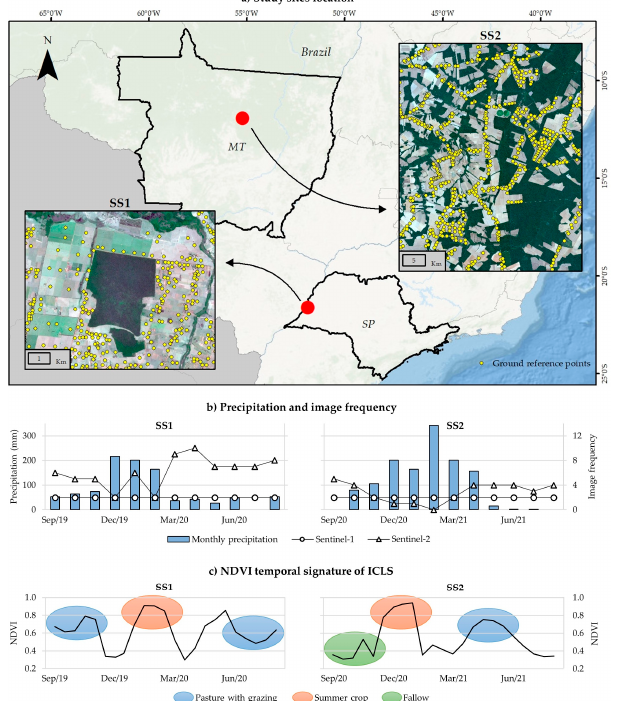
Figure 1. ( a ) Location of study sites and ground reference points; ( b ) frequency of Sentinel-1 and Sentinel-2 images used and precipitation rates over the season by study site; ( c ) NDVI temporal signatures of ICLS samples in Mato Grosso and Sao Paulo states, Brazil. The NDVI values were extracted from a sampled pixel inside an ICLS field in each study site. To better illustrate the pattern, the Savitzky–Golay filter was applied.